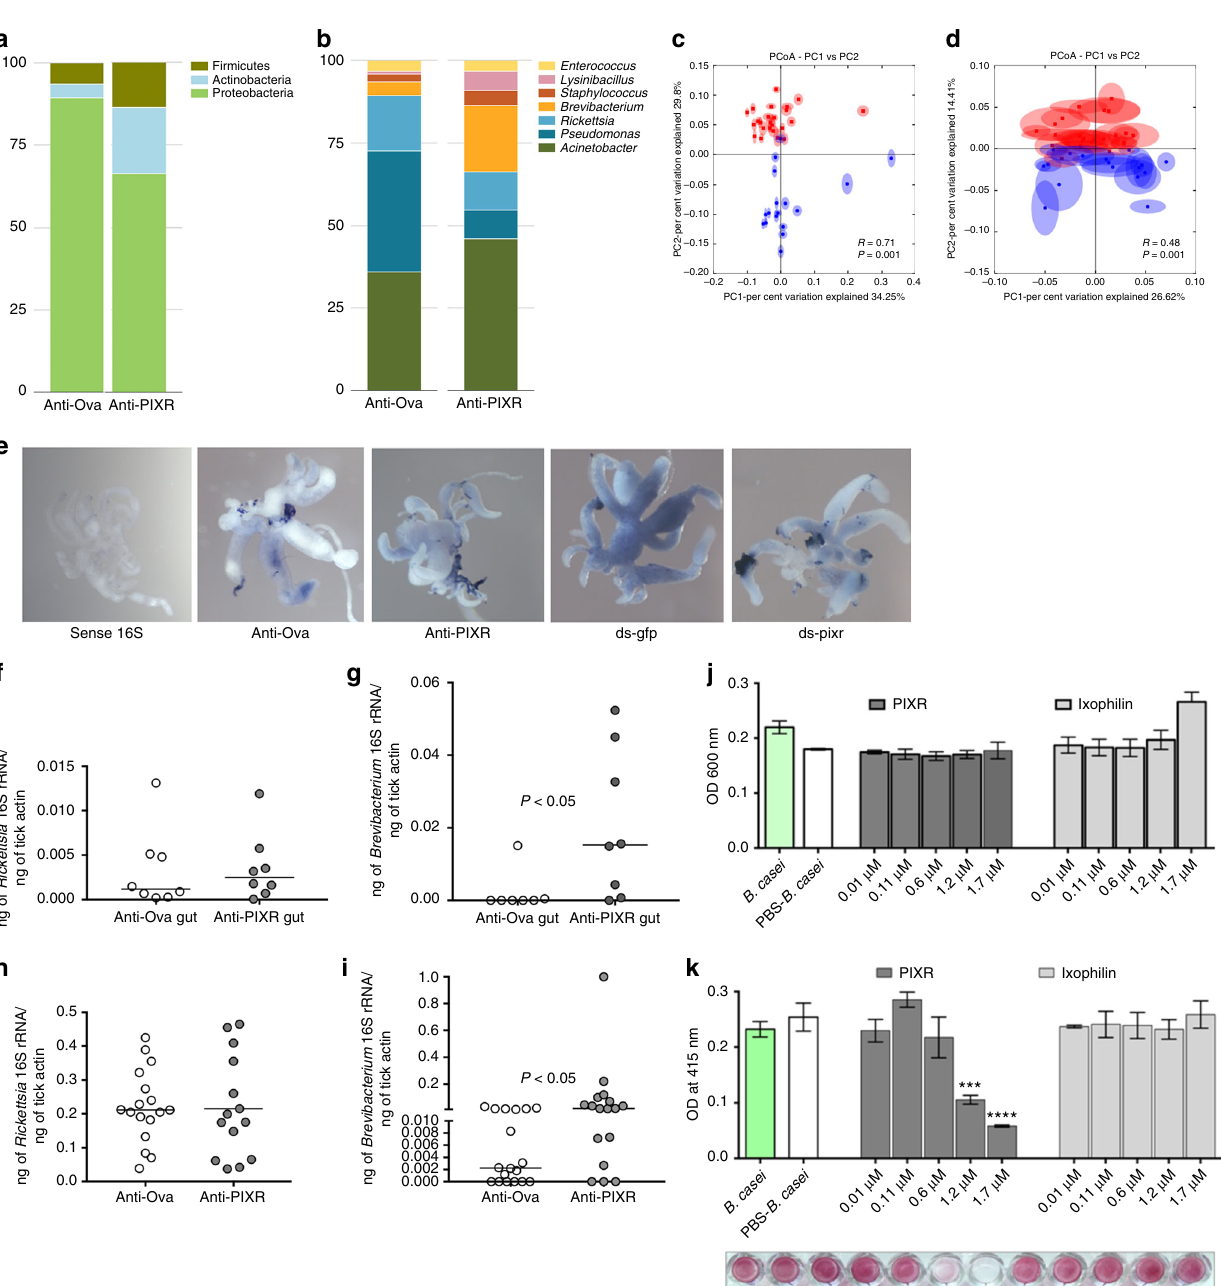
Fig. 7 PIXR abrogation alters the composition of tick gut microbiota. 16S rRNA amplicon sequence analysis of microbial communities of larvae that fed on ovalbumin-immunized (control) or rPIXR-immunized mice (PIXR): a phylum; b genera; c principal coordinate analysis of weighted; and d unweighted jack- knifed UniFrac distances of microbial communities between PIXR ( blue ) and control ( red ) larval ticks. Statistical signi fi cance determined by ANOSIM is indicated within each PCA plot; e whole-mount in situ hybridization of universal 16S rRNA probes in 48 h fed guts of nymphs fed on PIXR-immunized (anti- PIXR) mice or ds pixr-injected (ds pixr) nymphs showed restricted staining compared to that in guts of nymphs fed Ovalbumin-immunized (anti-Ova) or in ds gfp-injected (ds gfp) nymphs. qRT-PCR assessment of 16S rRNA transcript levels of: f Rickettsia ; g Brevibacterium in fed nymphal guts; h Rickettsia ; and i Brevibacterium in repleted larvae. Each data point in f – i represents a pool of three nymphal guts and fi ve larval ticks respectively. Mean values signi fi cantly different in a non-parametric Mann – Whitney test ( P < 0.05) indicated. j Growth of Brevibacterium casei cultures upon incubation with rPIXR or rIxophilin. k Bio fi lm formation of B . casei in presence or absence of rPIXR or rIxophilin. Results are mean ± s.e.m. of three biological replicates. A representative image of the safranin-stained bio fi lm is shown below the graph. Bacteria cultured without any added recombinant protein or with PBS served as controls. Asterisks represent statistical signi fi cance by one-way analysis of variance